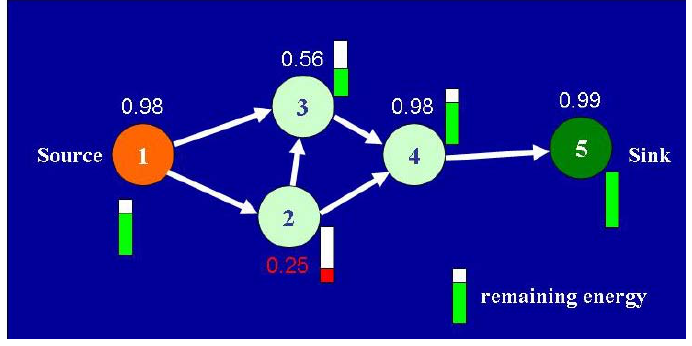
Figure 13. Energy consumption decrease the